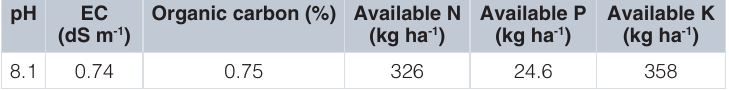
Table 1. Soil physical and chemical properties of the experimental site. pH EC Organic carbon (%) Available N (dS m -1 ) (kg ha -1